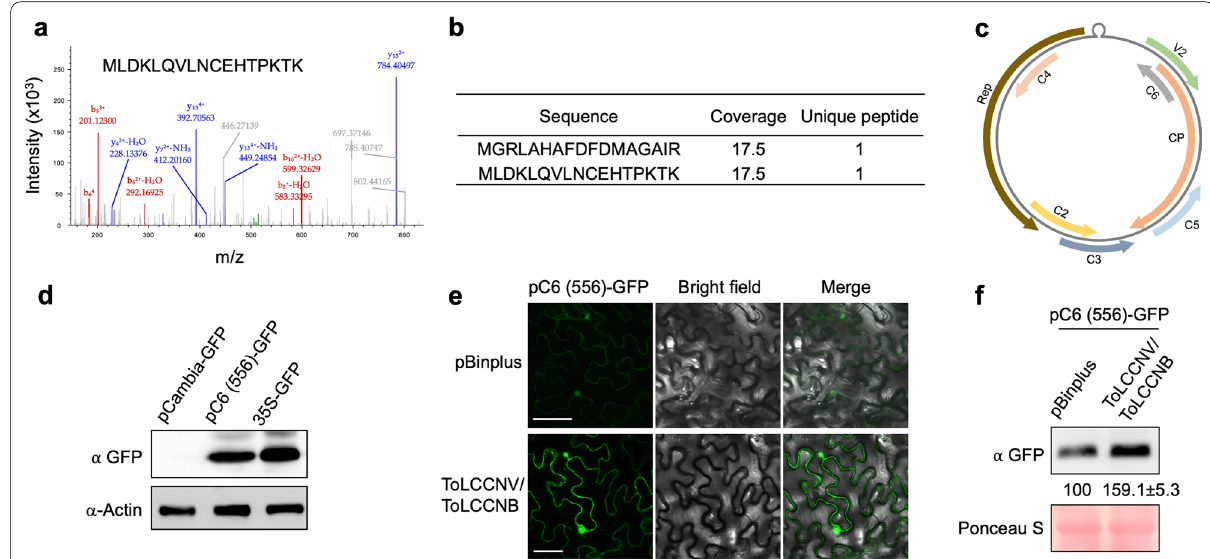
Fig. 1 Detection and sequence analyses of a begomovirus‑encoded C6 protein. a Detection of unique C6 peptides by mass spectrometry analysis in Nicotiana benthamiana plants infected with ToLCCNV/ToLCCNB. b MS spectrum identification of the unique‑peptides 74 MLDKLQVLNCEHTPKTK 90 and 1 MGRLAHAFDFDMAGAIR 17 in the ToLCCNV‑C6 protein. c Schematic representation of the genome organization of ToLCCNV. d Western